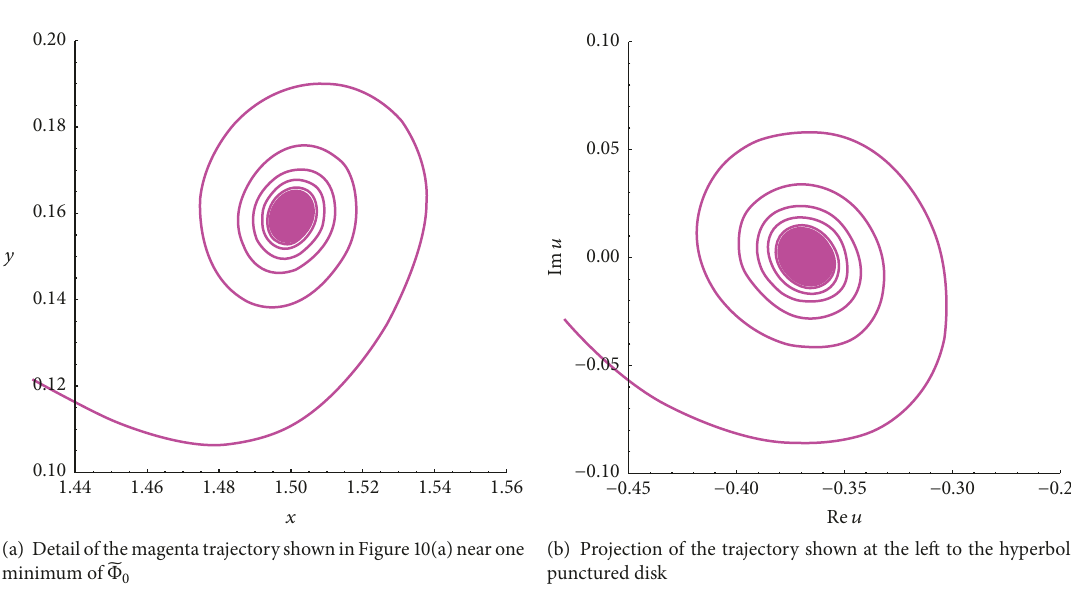
Figure 10: Numerical solutions for Φ = Φ 0 and 𝛼 = 𝑀 0 /3 .